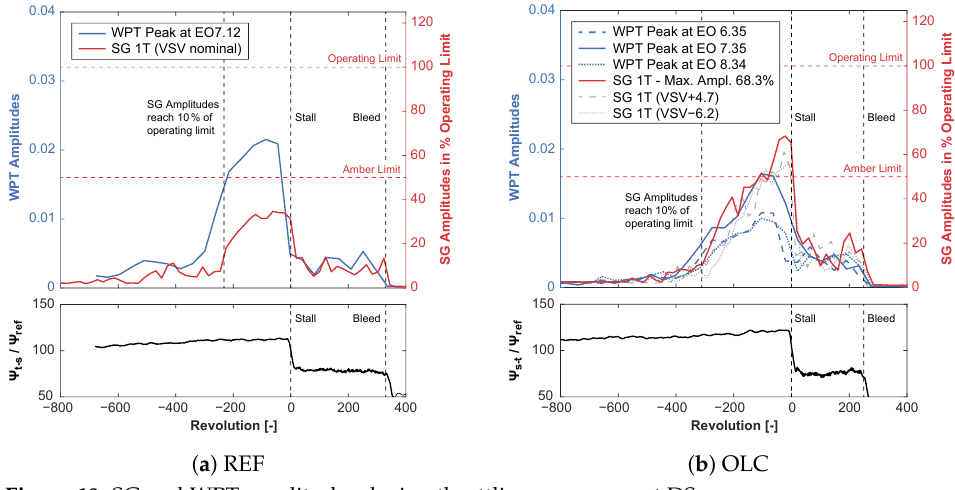
Figure 10. SG and WPT amplitudes during throttling maneuver at DS. For the REF configuration (see Figure 10a), it is visible that the WPT amplitudes for EO 7.12 began to rise rapidly at 300 revolutions before stall inception. The rise of the